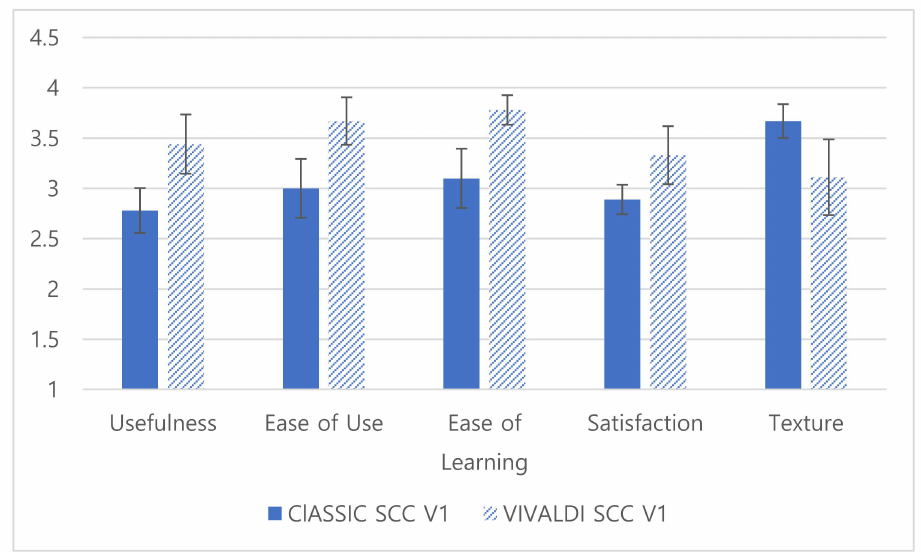
Figure 6. User experience evaluation: strongly disagree (one point)–strongly agree (four points).